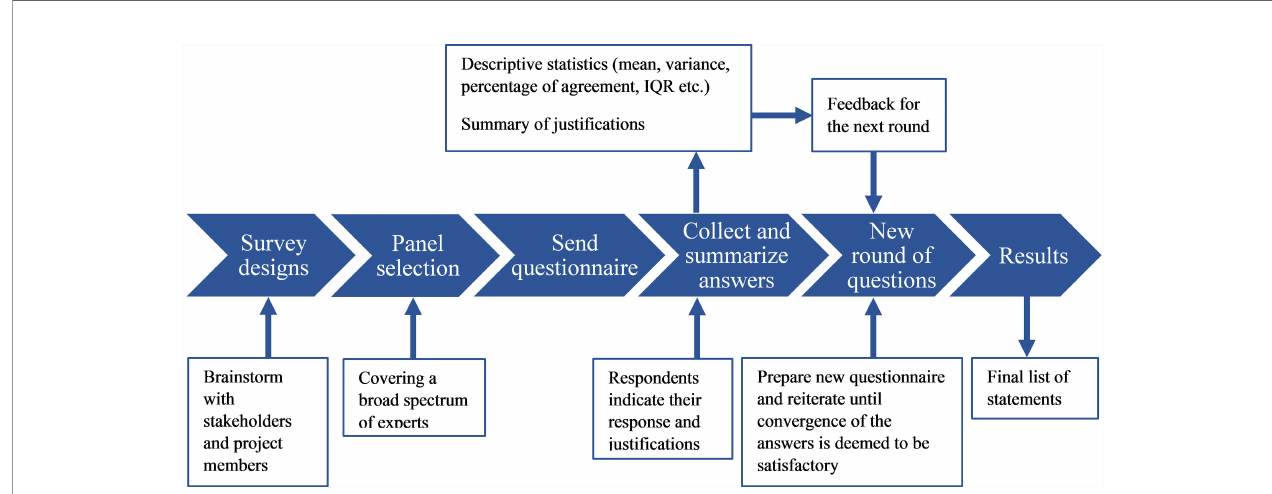
FIGURE 1 | Delphi method